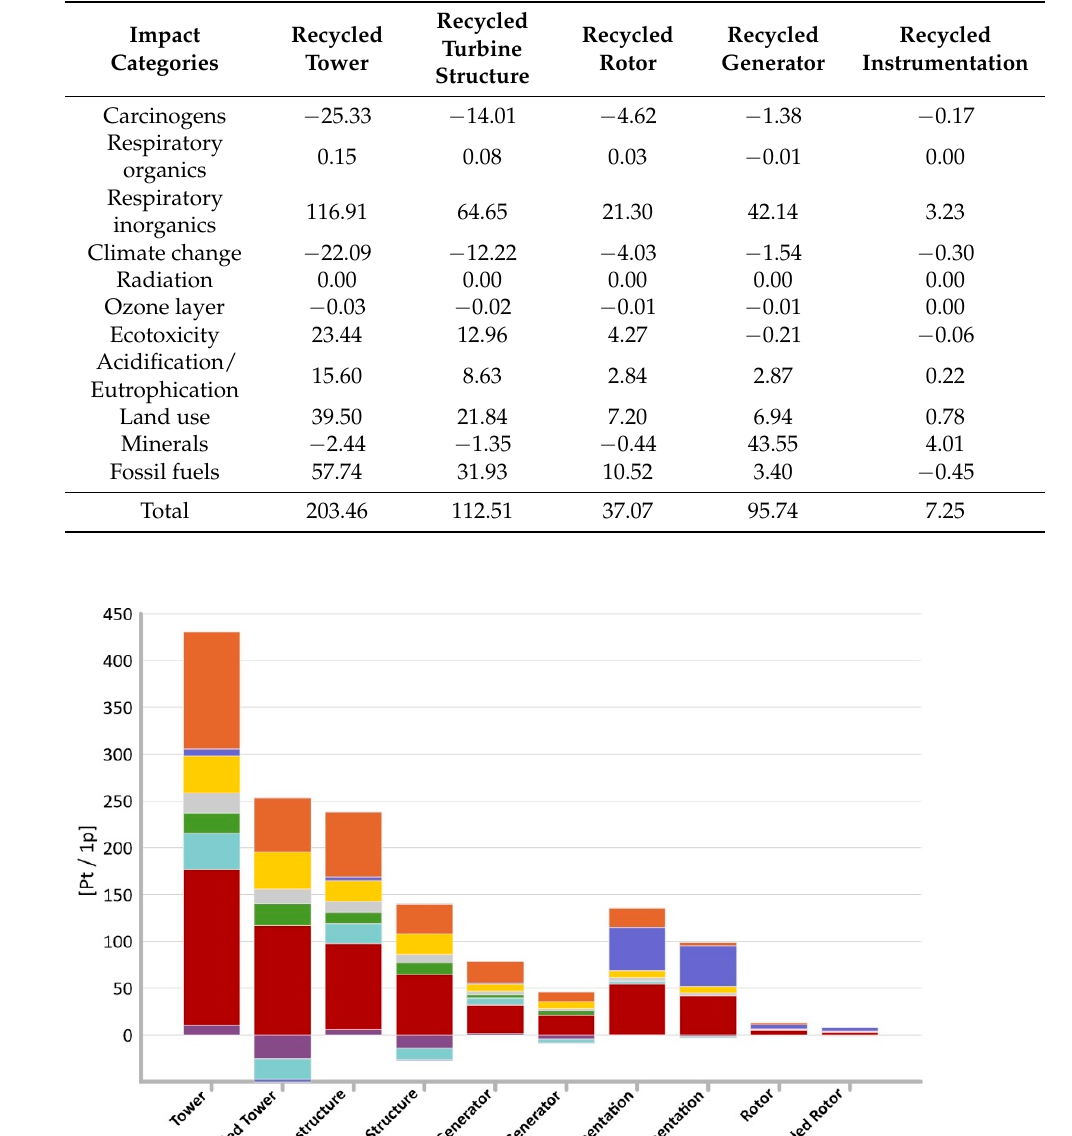
Table 3. Results of grouping and weighting of environmental impacts during the life cycle of an innovative 15 kW wind turbine—method with recycling (unit: Pt/1 p).